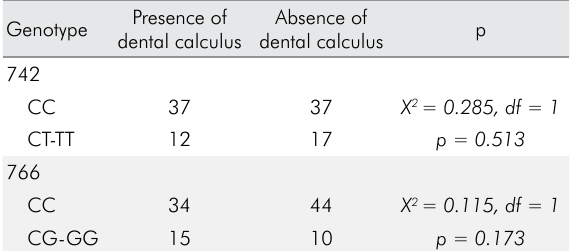
Table 1. Fetuin-A genotype distribution of cases according to groups (presence or absence of dental